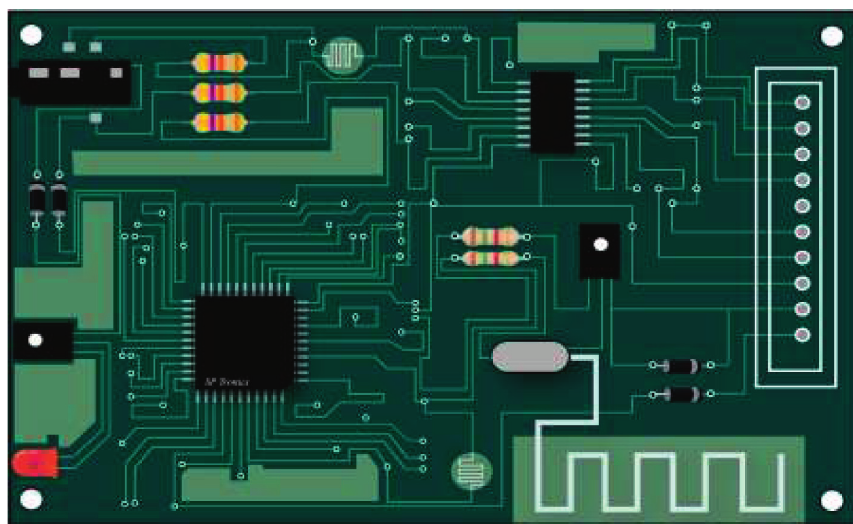
Figure 1: Schematic diagram of printed circuit boards.